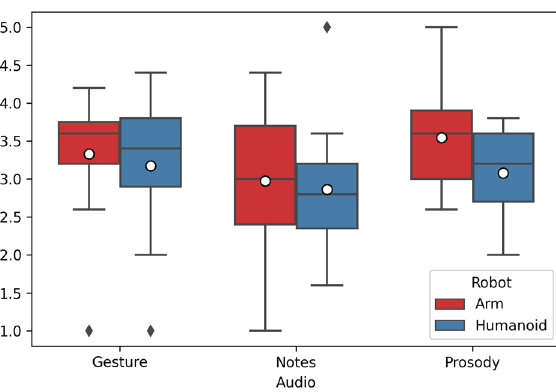
Figure 9: Box plot of likeability, comparing humanoid and arm across audio types. White dot indicates mean, middle line is median, and black dots are